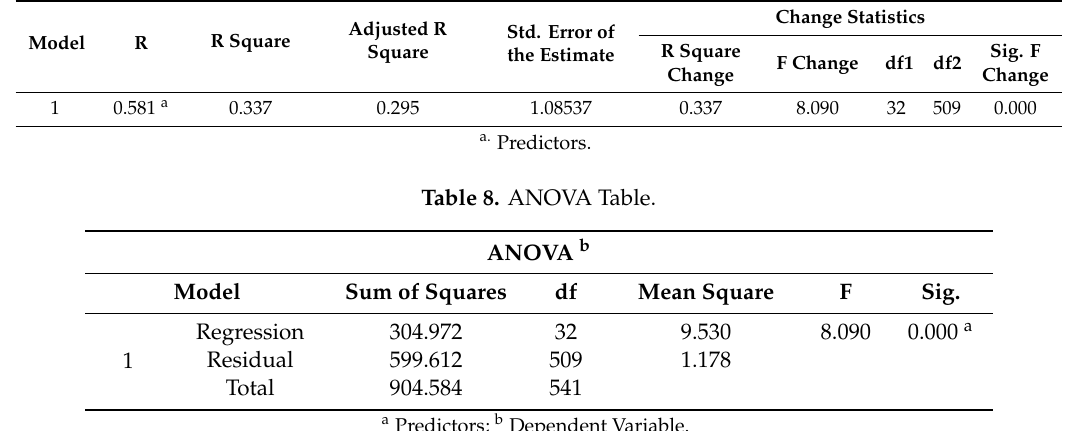
Table 7. Model Summary.